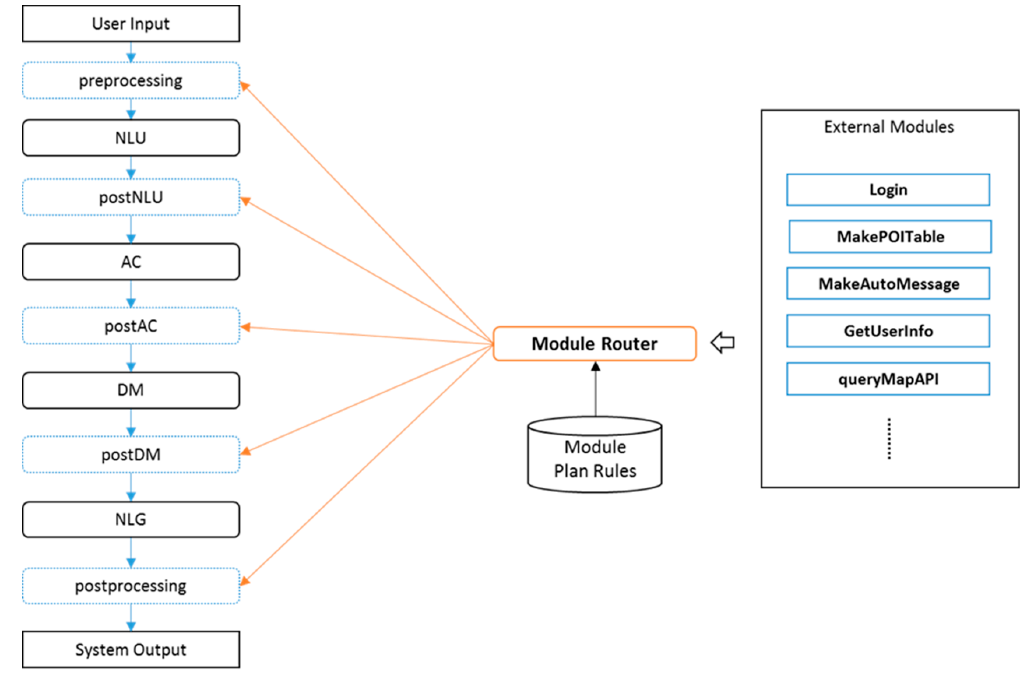
Figure 3. External modules and module router.